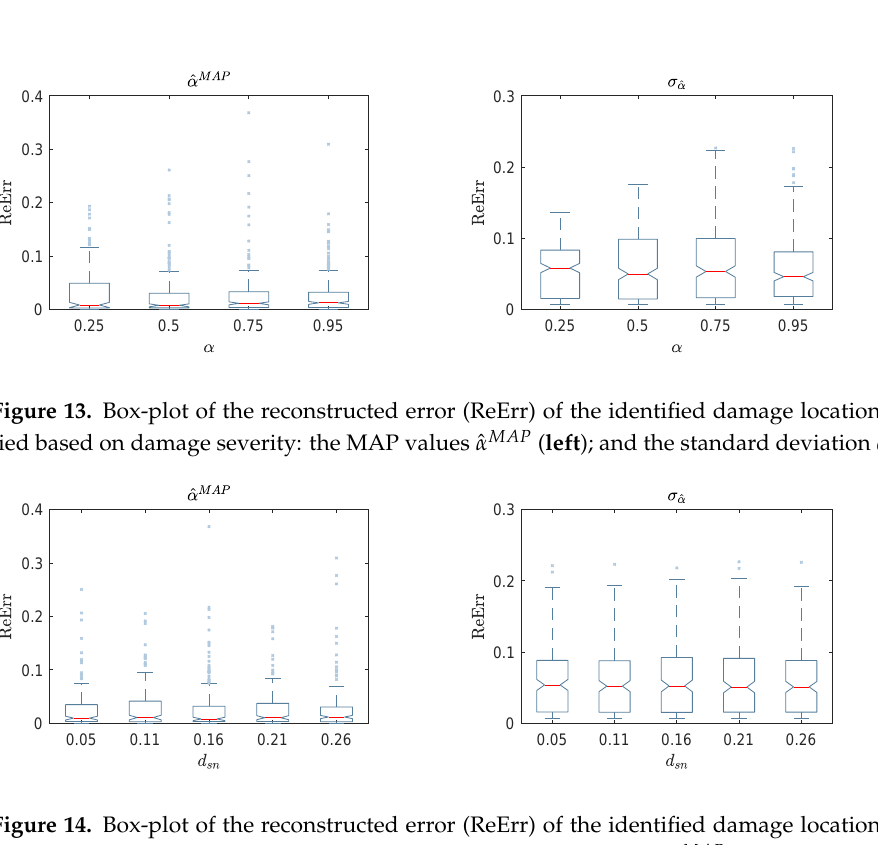
Figure 14. Box-plot of the reconstructed error (ReErr) of the identified damage location ˆ α , classi- fied based on the distances between sensors d sn : the MAP values ˆ α MAP ( left ); and the standard deviation σ ˆ α ( right ).